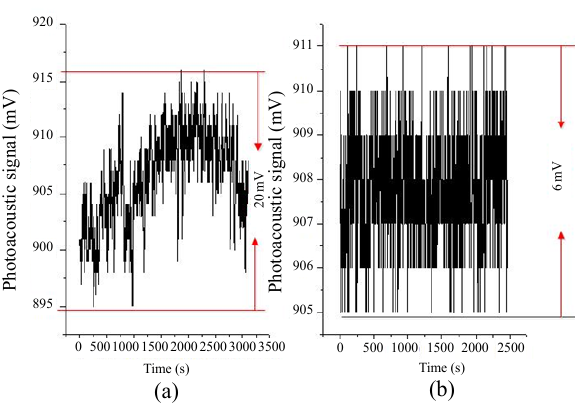
Fig. 9 Photoacoustic signal in: (a) wavelength stabilization scheme and (b) calibration technique.